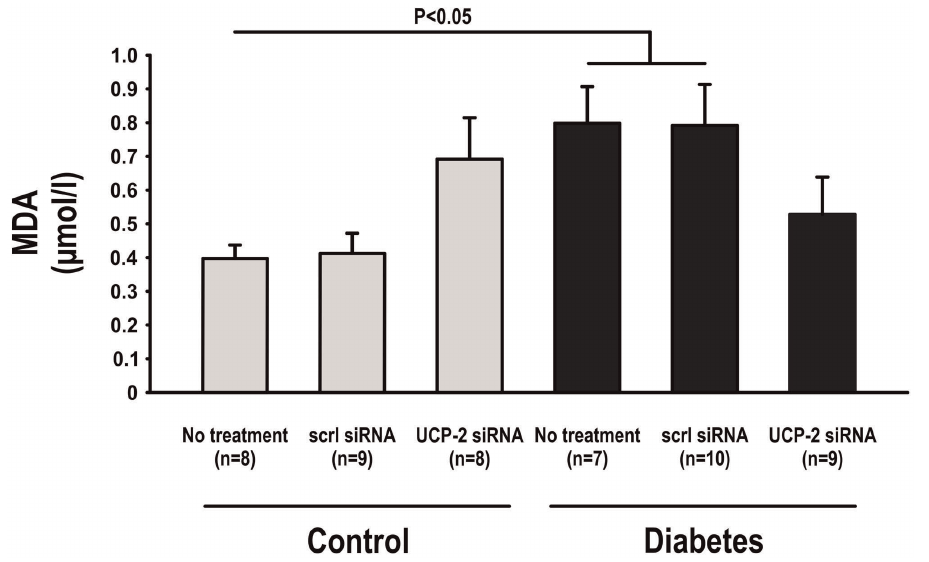
Figure 8. Whole-body oxidative stress levels measured as circulating MDA levels in control and diabetic animals with and without scrambled or UCP-2